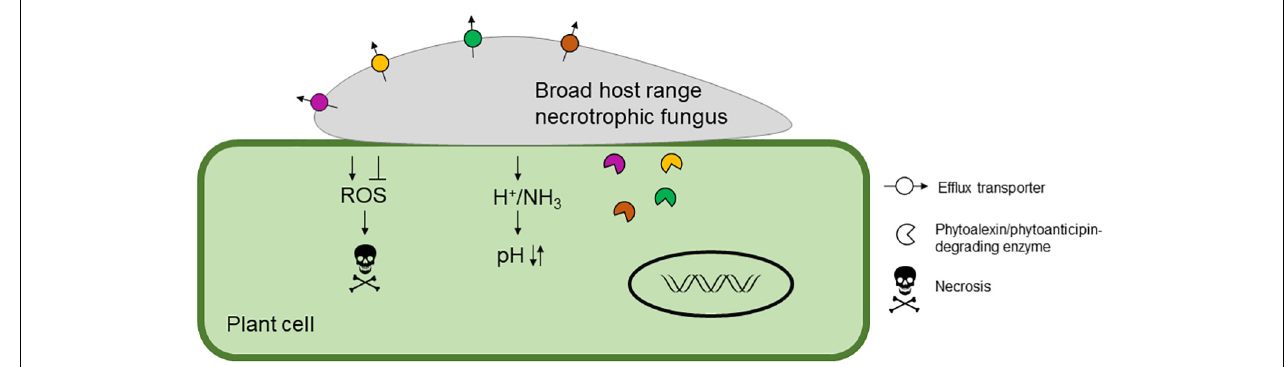
FIGURE 1 | A schematic representing the molecular features of broad host range necrotrophic fungal pathogenesis. Typical molecular mechanisms to infect the host are shown including modulation of host reactive oxygen species (ROS), which is generally suppressed during initial infection and then promoted at later stages to induce necrosis. The host pH is modulated by the secretion of acid(s) to reduce the pH and/or ammonia to increase the pH resulting in suppression of host immunity and increased virulence. Finally, host-derived antifungal secondary metabolites, phytoalexins and phytoanticipins, are detoxified by efflux or degradation. Typical broad host range necrotrophic fungi harbor an array of detoxification enzymes and transporters indicated by the different